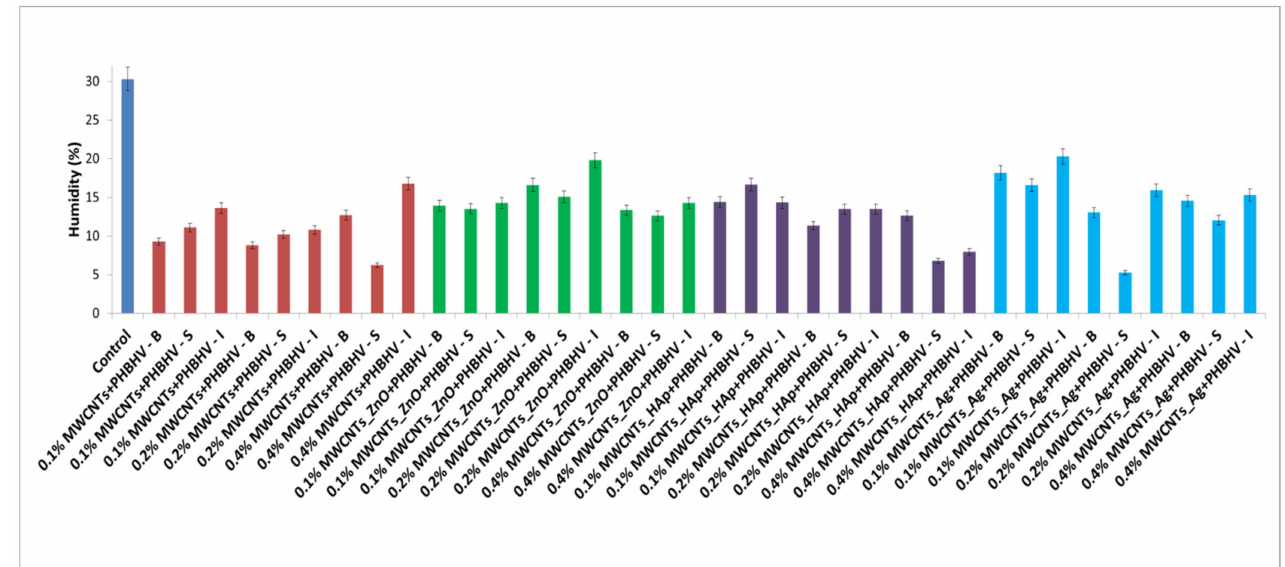
Figure 7. Obtained results from U test for untreated and treated